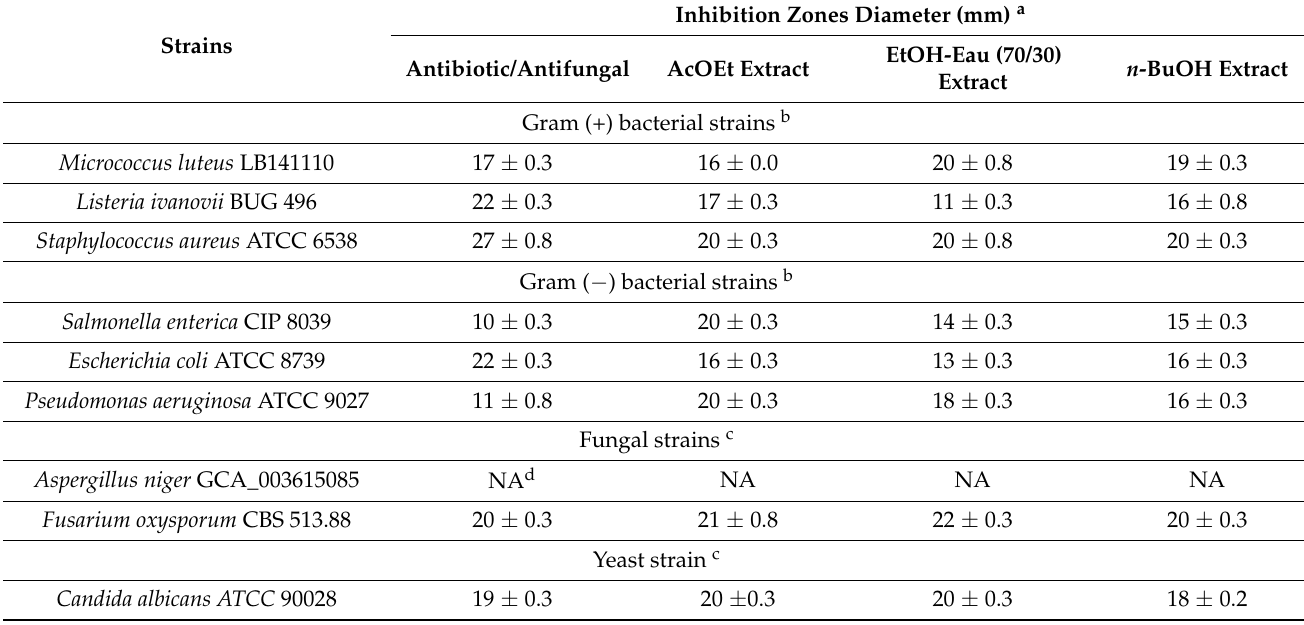
Table 5. Antimicrobial activity of EtOAc, hydroethanolic, and n -BuOH leaf extracts of A. arboreum against bacterial, fungal, and yeast strains by the disc